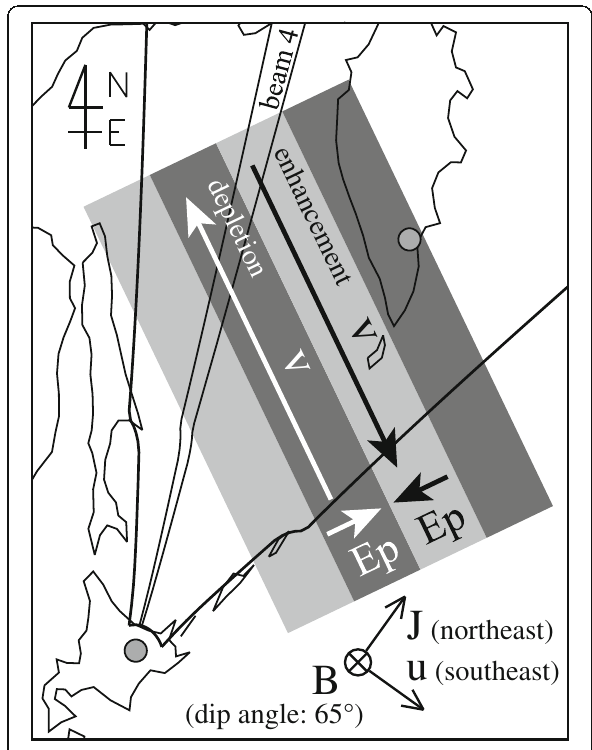
Fig. 21 Schematic interpretation of the optical and radar events observed on 8 December 2007 by the Hokkaido radar. The dark gray and light gray shaded regions represent the depletions and enhancements, respectively in the 630-nm airglow intensity. Reproduced from Fig. 4 of Suzuki et al.